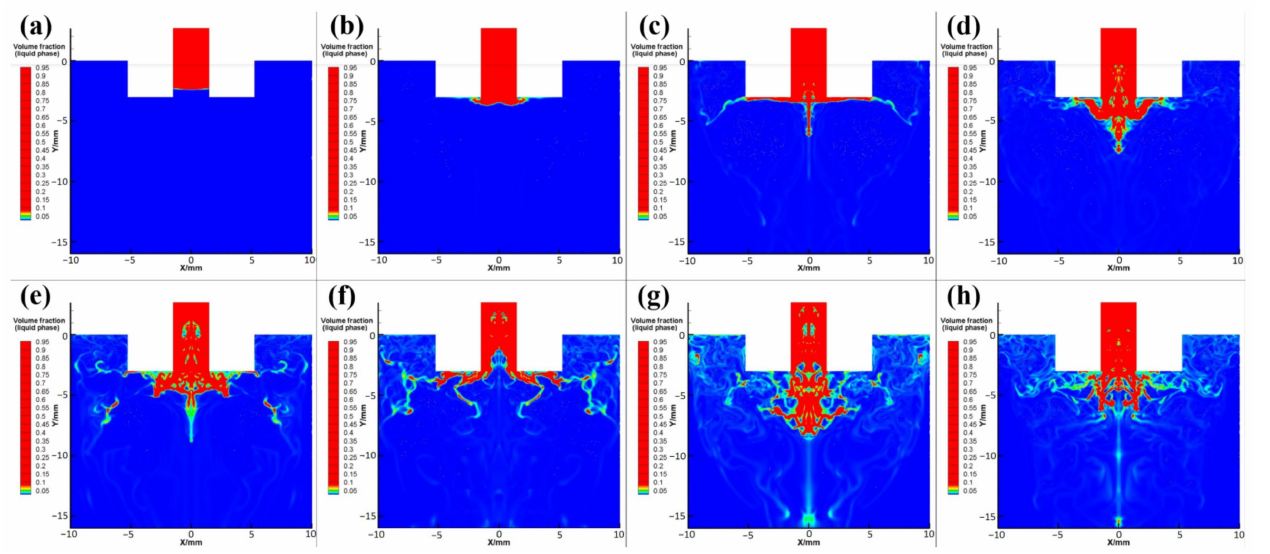
Figure 2. Flow pattern images of superalloy melt in the primary atomization process after of different flow times: ( a ) 4.0 ms, ( b ) 5.0 ms, ( c ) 6.0 ms, ( d ) 7.0 ms, ( e ) 8.0 ms, ( f ) 9.0 ms, ( g ) 10.0 ms, and ( h ) 11.0